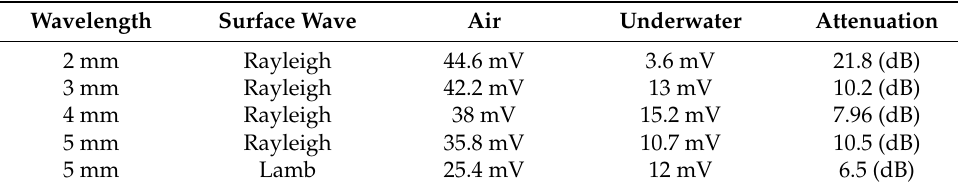
Table 3. Peak to peak value and attenuation of experimental